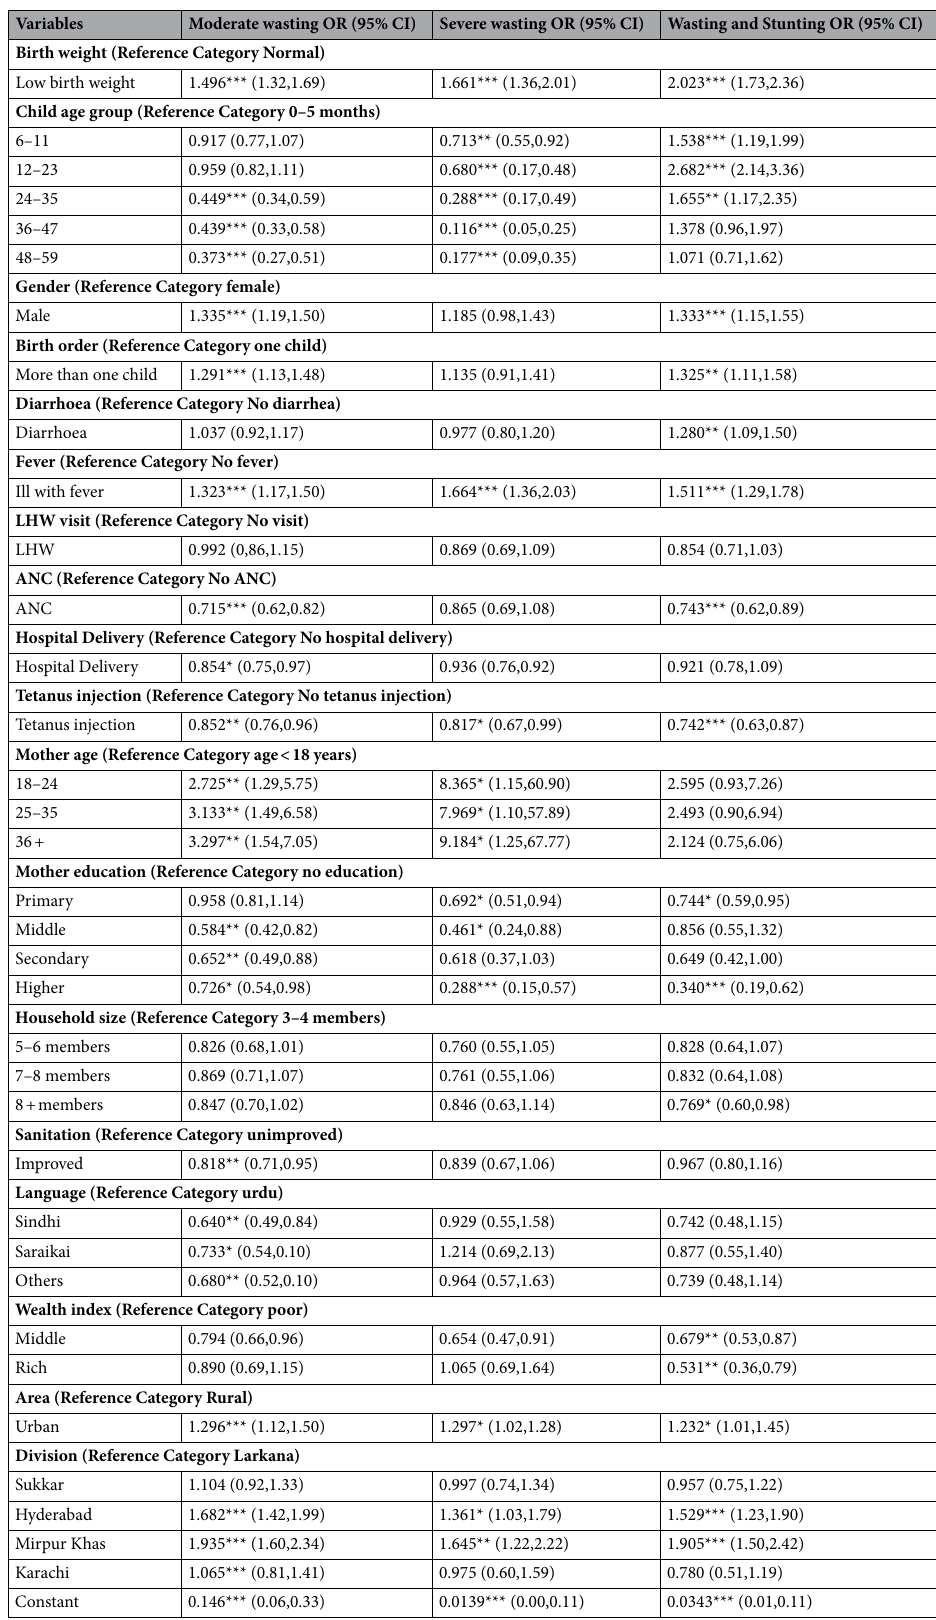
Table 4. Multivariable regression analysis of moderate, severe wasting and both with other